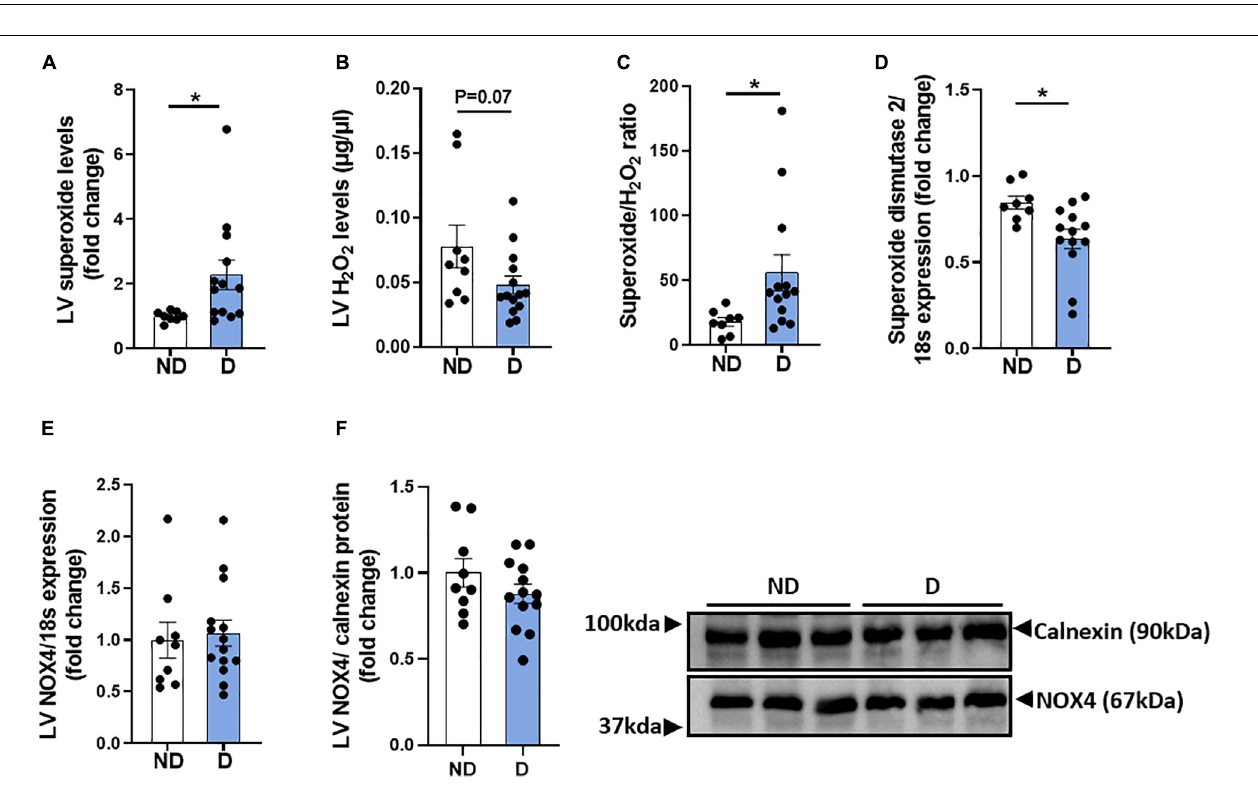
FIGURE 4 | LV ROS production in diabetic mice. (A) LV Superoxide generation, (B) LV H 2 O 2 generation, (C) LV superoxide/H 2 O 2 ratio. Markers of LV ROS generation; gene expression of (D) superoxide dismutase-2 and (E) NADPH oxidase-4 (NOX4), and (F) protein abundance of NOX4. Data represented as mean ± SEM. n = 8–14 per group (note individual data points). Data analysis used unpaired t -test. * P < 0.05. ND, non-diabetic; D,